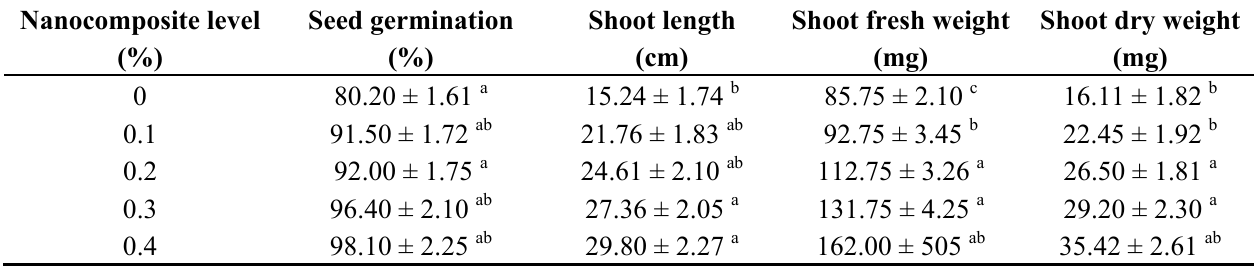
Table 1. Effect of different levels of PHNC on seed germination and seedling